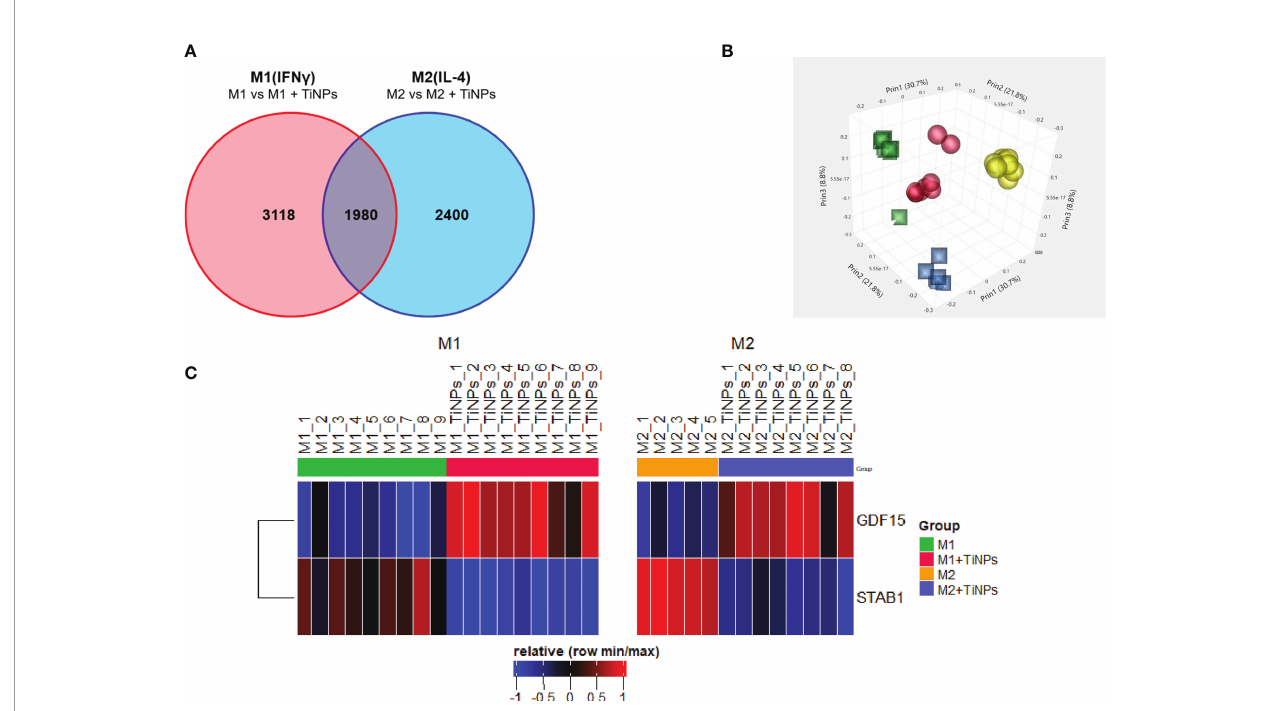
FIGURE 1 | Summary of microarray analysis of the effect of titanium nanoparticles on transcriptome of human in fl ammatory and healing macrophages. (A) Venn ’ s diagram of differentially expressed genes in macrophages cultured in presence of TiNPs. Each number represents the number of genes differentially expressed in response to TiNPs. Each circle represents a population of macrophages with a different stimulation: Red – M1(IFN g ) and Blue – M2(IL-4). Intersecting points represent the number of genes differentially regulated by TiNPs in both stimulations conditions. (B) Clustering of the microarray data in a 3D scatterplot. Each sphere represents genes from one donor. Clustering of data from M1(IFN g ) is represented by yellow spheres – Control and red spheres – TiNPs); clustering of data from M2 (IL-4) is represented by blue squares – Control and green squares - TiNPs). (C) Heatmap of relative expression of stabilin-1 and GDF-15. Differential expression is shown between Control and TiNPs conditions M1 and M2, respectively. The number of donors differs for every condition depending on the availability of